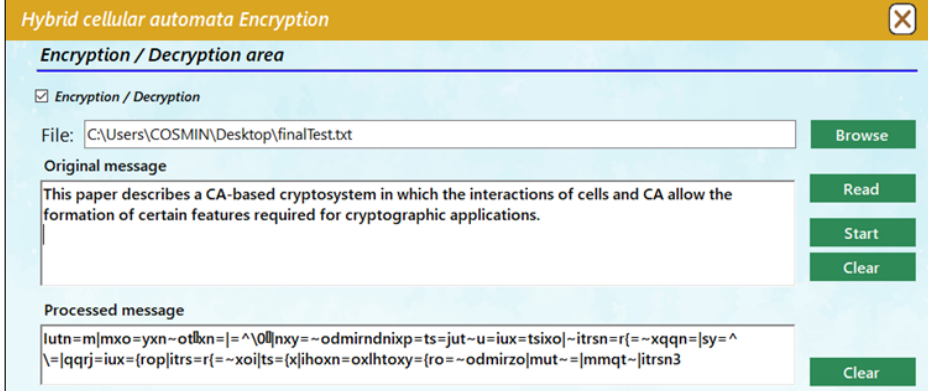
Figure 5. Results of the encryption process.